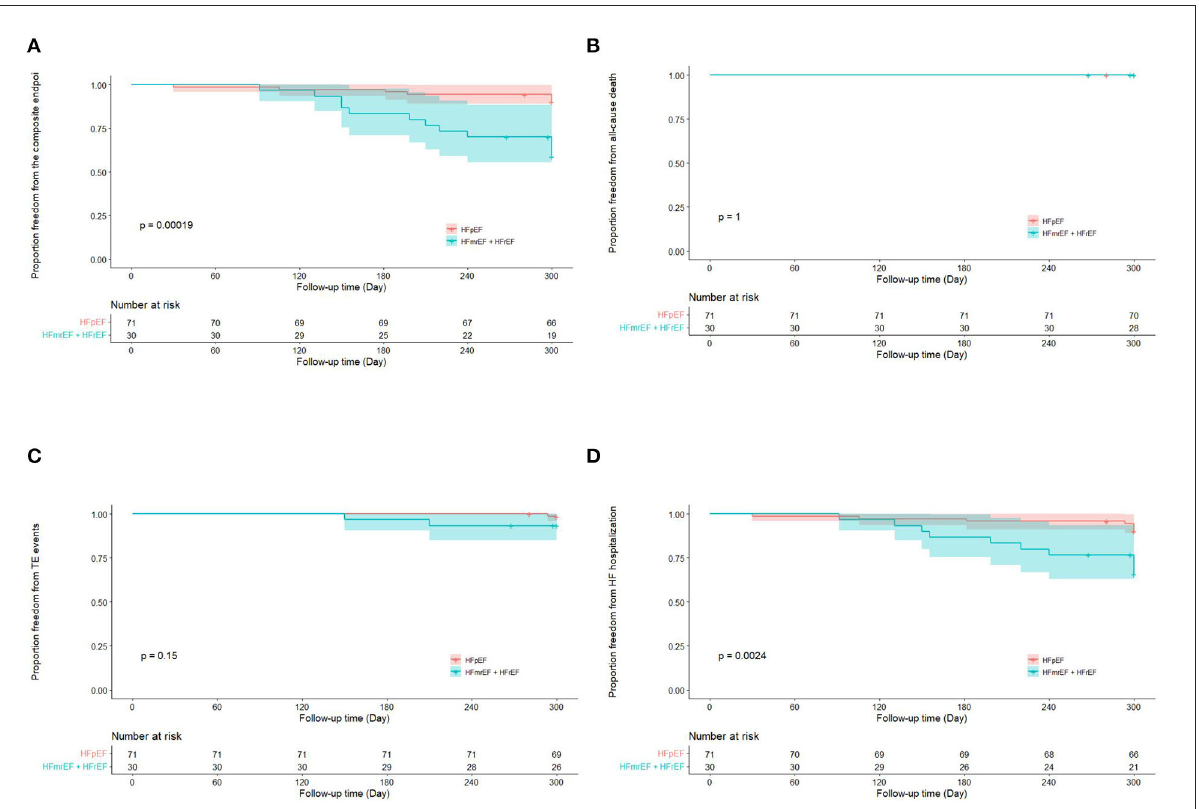
FIGURE3 Kaplan–Meier curves showing the incidence of the composite endpoint (A) , all-cause death (B) , thromboembolic events (C) , heart failure hospitalization (D) in heart failure with preserved ejection fraction and heart failure with mid-ranged ejection fraction + heart failure with reduced ejection fraction groups. AF, atrial fibrillation; TE, thromboembolism; HF, heart failure; HFpEF, heart failure with preserved ejection fraction; HFmrEF, heart failure with mid-range ejection fraction + heart failure; HFrEF, heart failure with reduced ejection